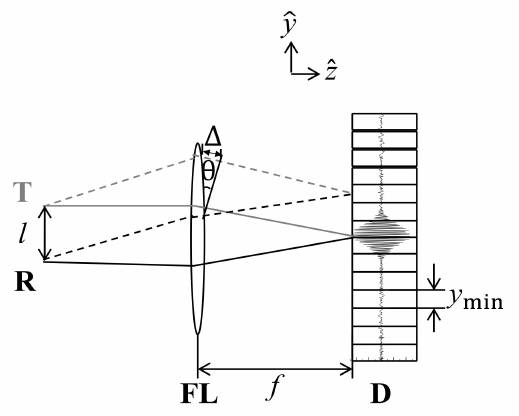
Figure 2. Schematic view of interferogram detection. T and R are transmitted and reflected beams, FL is a focusing lens and D is the one-dimensional